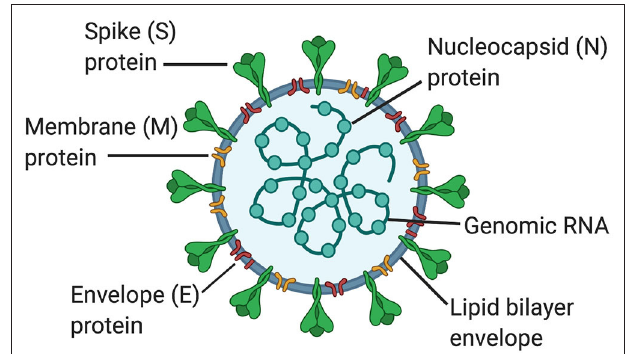
FIGURE 1 | Structure of coronaviruses. In a lipid bilayer envelope, CoVs consist of a spike (S) protein, a membrane (M) protein and an envelope (E) protein. Inside the lipid bilayer envelope, the nucleocapsid (N) protein and the genomic RNA comprise the inner core.